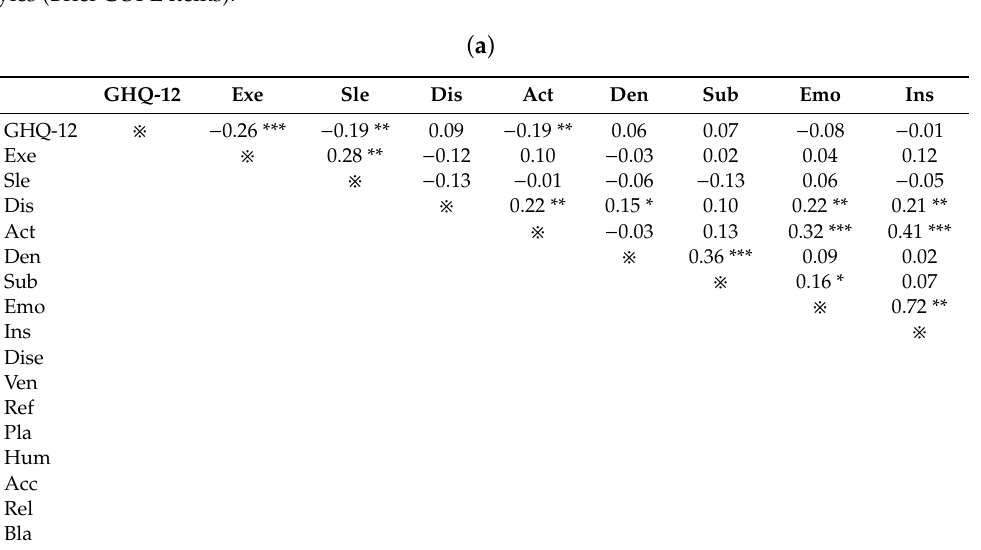
Table 1. Pearson correlations for associations between psychological distress, health habits, and coping styles (Brief COPE